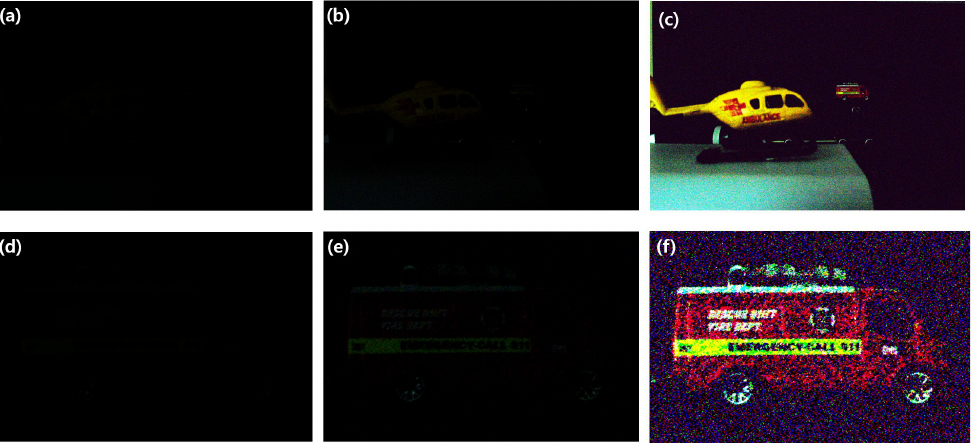
Figure 8. Elemental images and estimated images under photon-starved conditions. ( a ) 13th elemen- tal image, ( b , c ) estimated images of ( a ) by computational photon counting imaging with 97,344 and 973,440 photons, respectively, ( d ) new elemental image for ROI of ( a , e , f ) estimated image of ( d ) by computational photon counting imaging with 97,344 and 973,440 photons, respectively.